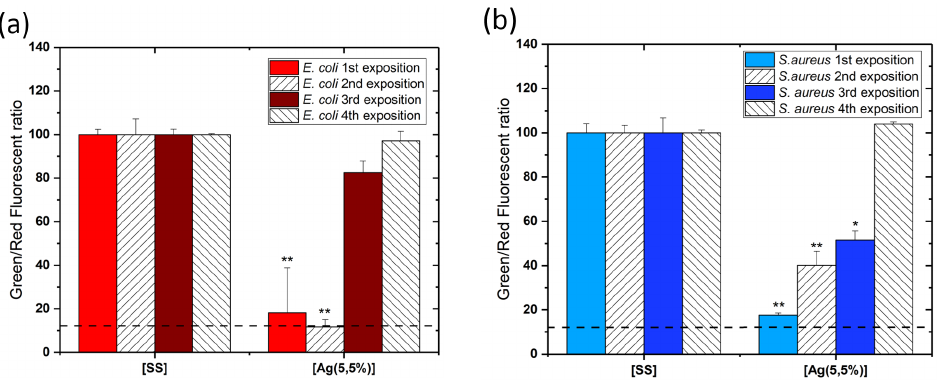
Figure 6. Diagram showing the standardized experimental results of the viability test using LIVE/DEAD BacLight Bacterial Viability Kits on the reference sample stainless steel substrate [SS] and the carbon matrix containing 5.5% of Ag [Ag(5.5%)]. Every exposure entails placement of a new set of fresh bacteria on the surface of the same coating. ( a ) shows results of E. coli (in red) and ( b ) S. aureus (in blue). Data are presented as the mean ± SD ( = 3 ). Results of the Mann–Whitney statistical test are shown in the graph (* indicates p < 0.05 and ** indicates p < 0.01).